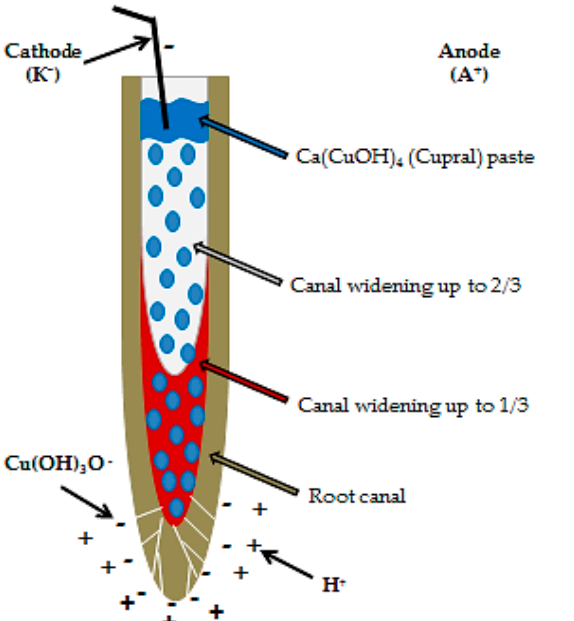
Scheme 2. Possible mechanism of ion electro-transmission in the radicular canal during